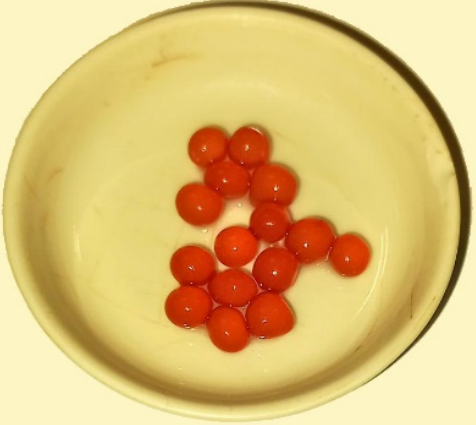
Figure 2. Calcium alginate beads with entrapped Rhodopseudomonas sp. cells. One thousand six hundred and thirty-seven beads, corresponding to 61.5 mL of total volume and 50.2 mg of the immobilized cells, were transferred to the cylindrical PBR at a 0.22 L working volume (Figure 3). The PBR was then filled with van Niel’s medium for H 2 production, sealed, and left in the dark for 16 h to support the anaerobiosis process. Subsequently, the PBR was transferred under light conditions to start the H 2 photofermentation process. The ORP showed a typical pattern, with a sharp decrease from the positive to the negative values, which was followed by a stabilization between − 430 mV and − 500 mV, which is attributed to the anaerobic conditions that were obtained (Figure